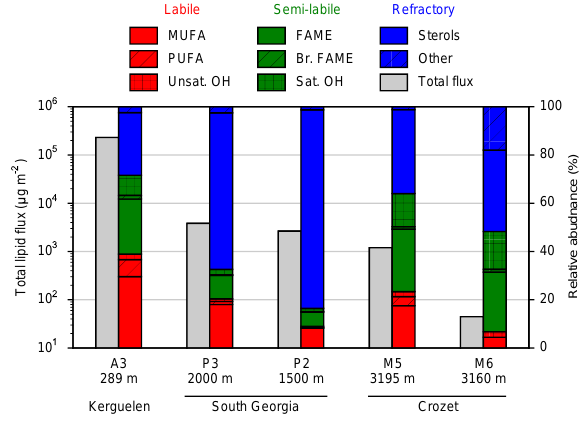
Figure 2. Total lipid fluxes (grey bars, left axis) integrated over the sediment trap deployment periods (Table 1) and the relative con- tribution of lipid classes (coloured bars, right axis) to this total flux from five moored sediment trap deployments in the Southern Ocean. Individual compound fluxes, concentrations and relative contribu- tions are included in Supplement Tables S1–S5. A full list of the compounds categorized as others can also be found in the Supple- ment